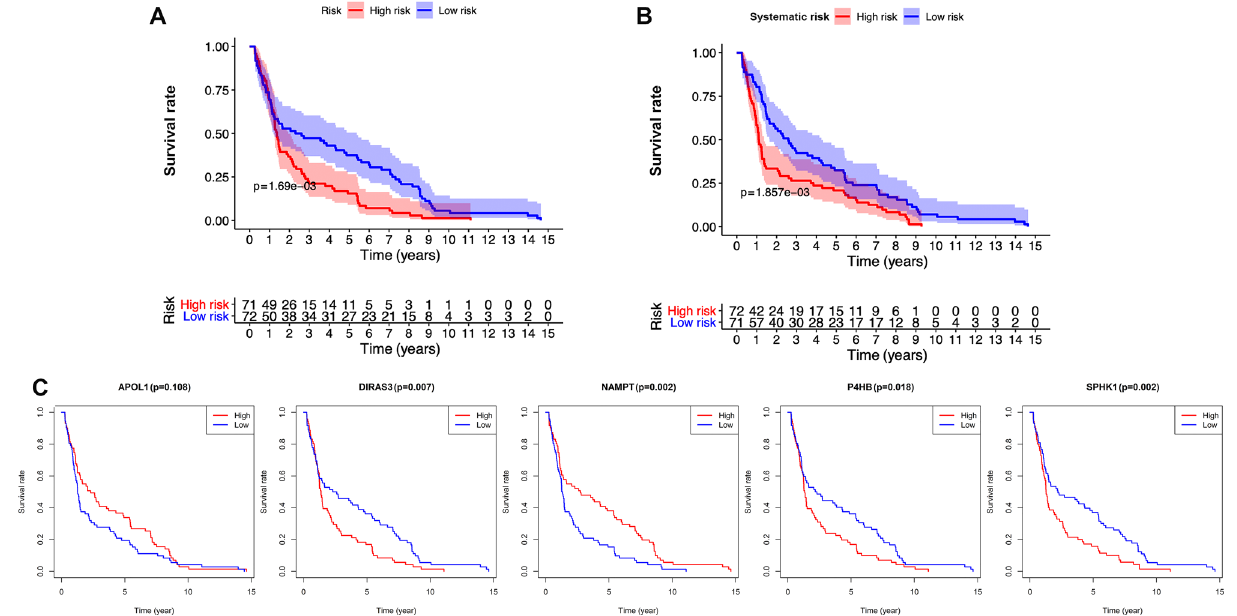
Figure 10. External validation of both signatures. ( A ) Validation of PDEARGs-based signature. ( B ) Validation of systematic signature. The 95% confidence interval was shown as a light-colored background around the Kaplan–Meier curve. ( C ) Survival analysis of five selected PDEARGs in external cohorts. The median expression level was used as the cut-off